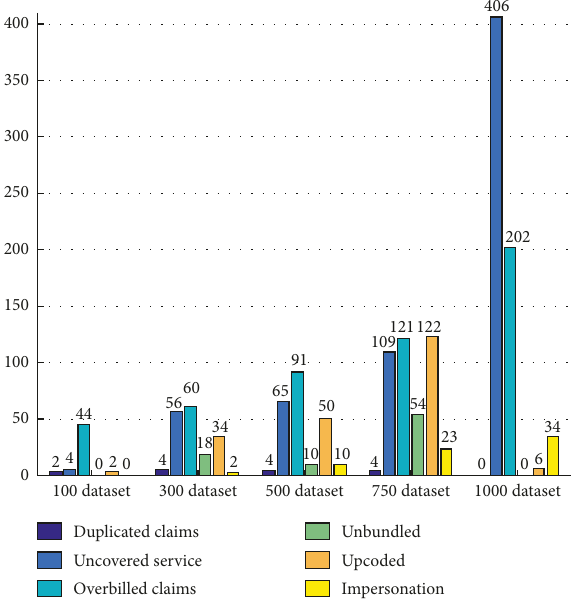
Figure 16: Chart of types of fraudulent claims.